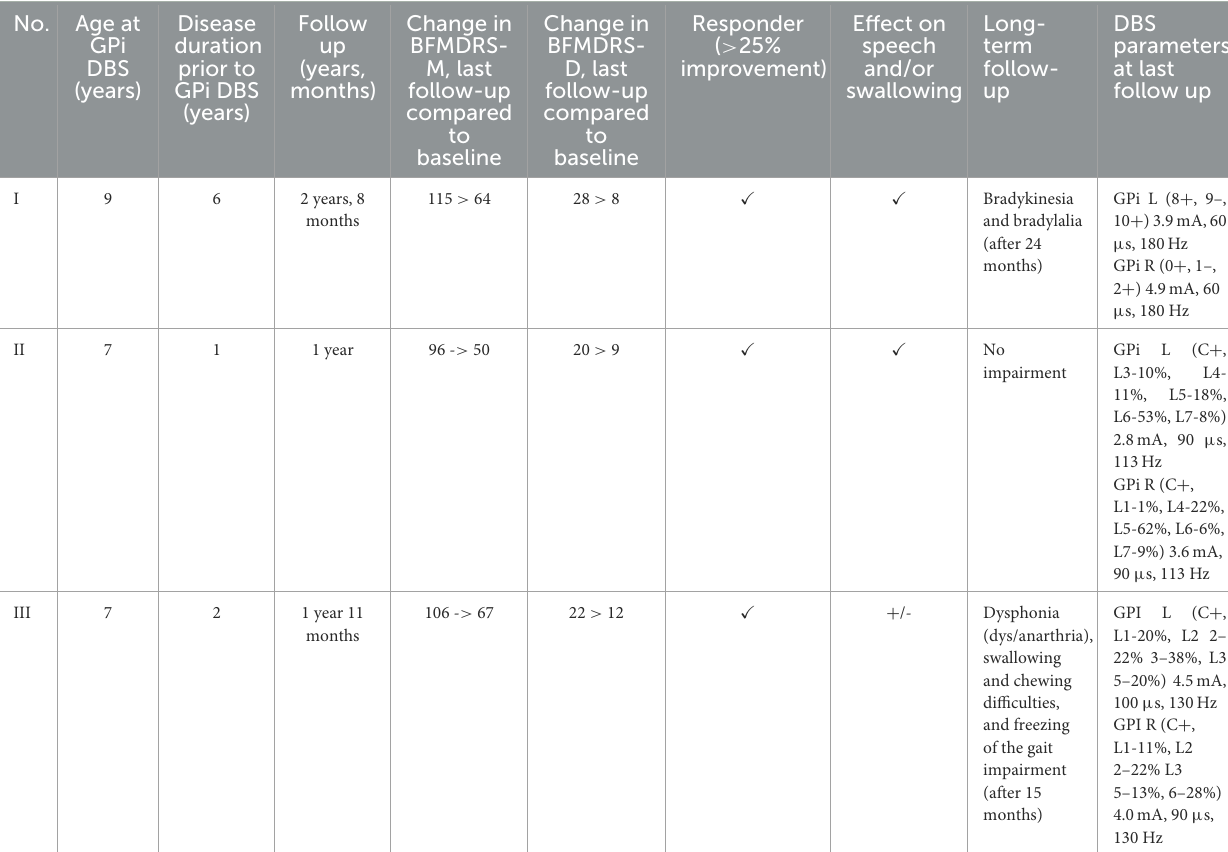
Responder ( > 25% improvement)